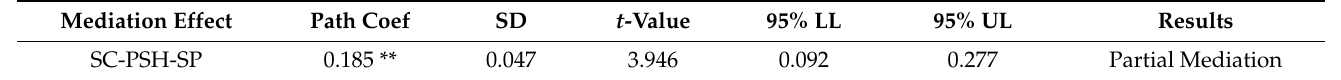
Table 8. Direct and indirect mediation